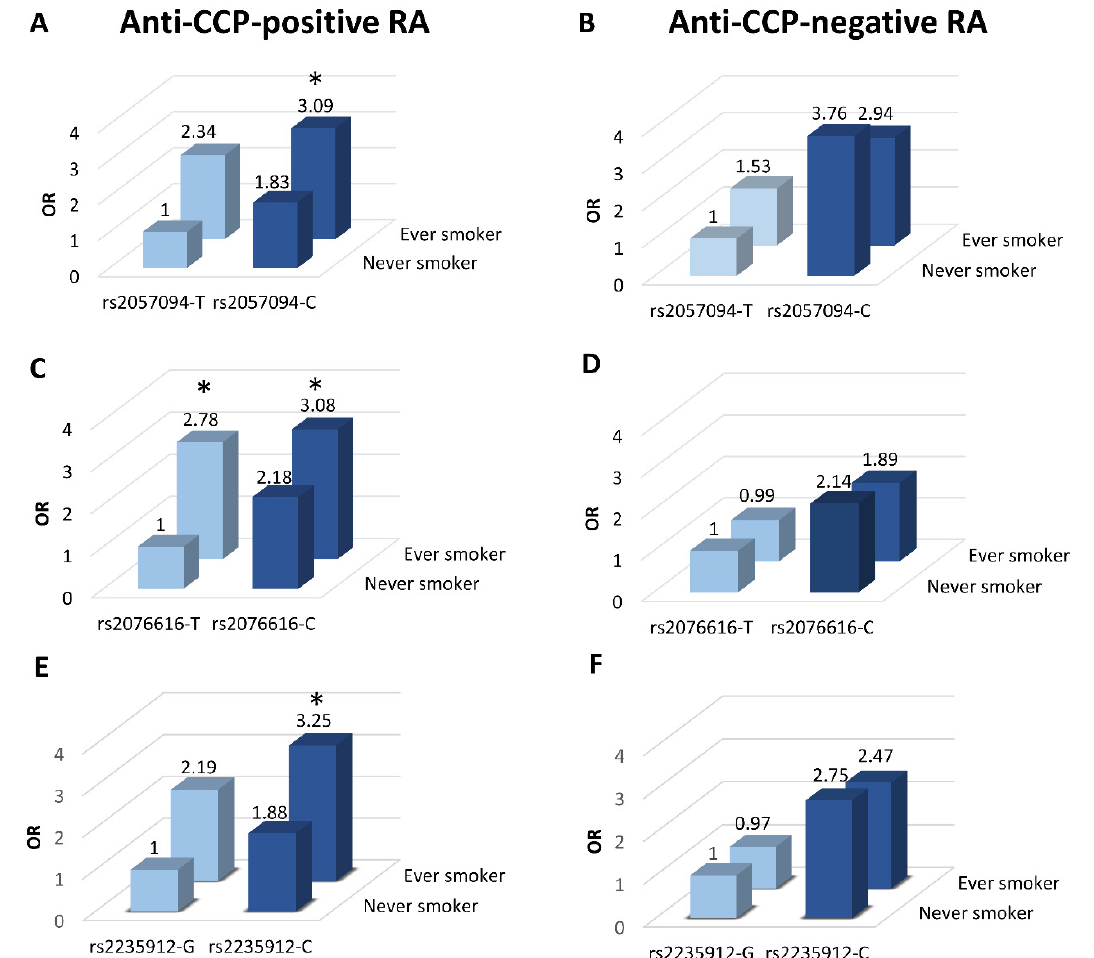
Figure 1. Influence of peptidylarginine deiminase gene 2 ( PADI2 ) single nucleotide polymorphisms (SNPs) on the risk of rheumatoid arthritis (RA) among subjects with self-reported periodontitis. The influence of PADI2 SNPs rs2057094 ( A , B ), rs2076616 ( C , D ) and rs2235912 ( E , F ) on risk of anti-CCP– positive ( A , C , E ) and anti-CCP–negative RA ( B , D , F ) is shown. Bars represent cumulative odds ratio (OR) due to homozygosity for the major allele (light blue bars) or carriage of the minor allele (dark blue bars) and smoking status. Bars marked with “1” denote reference conditions. * p < 0.05. All OR were adjusted for age and